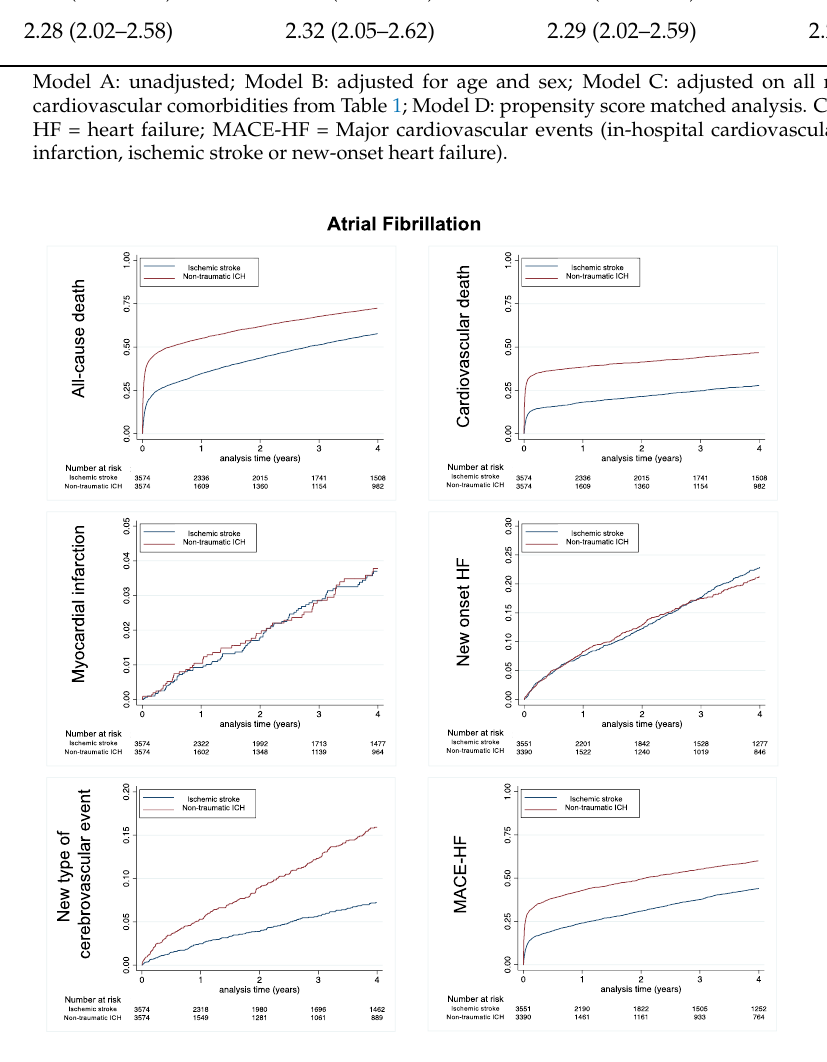
Figure 2. Cumulative incidences for all-cause death ( top left panel ), cardiovascular death ( top right panel ), myocardial infarction ( middle left panel ), new onset heart failure ( middle right panel ), new type of cerebrovascular event (non-traumatic ICrH for patients with history of ischemic stroke and ischemic stroke for patients with history of non-traumatic ICrH, ( left lower panel ) and MACE-HF ( right lower panel ) during follow-up in the matched populations with AF. MACE-HF = Major cardiovascular events (in-hospital cardiovascular death, myocardial infarction, ischemic stroke or new-onset heart failure). ICH: non-traumatic intracranial